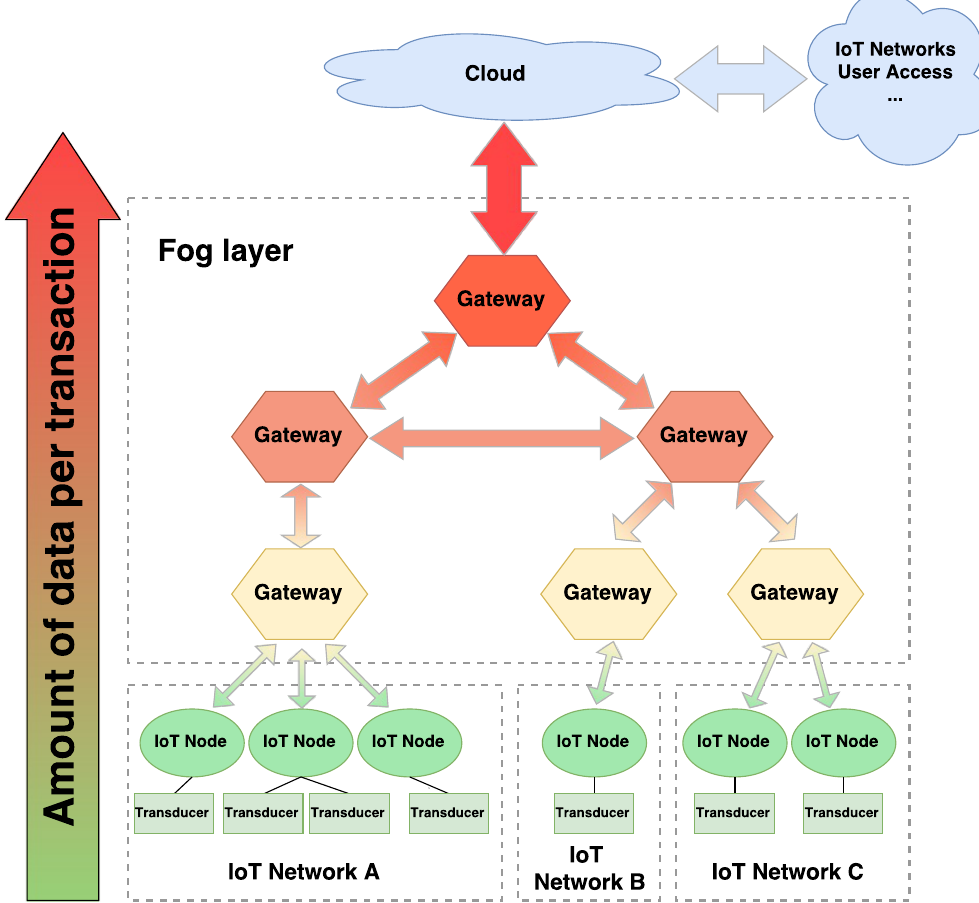
Figure 1. Generic Internet of Things (IoT) fog computing